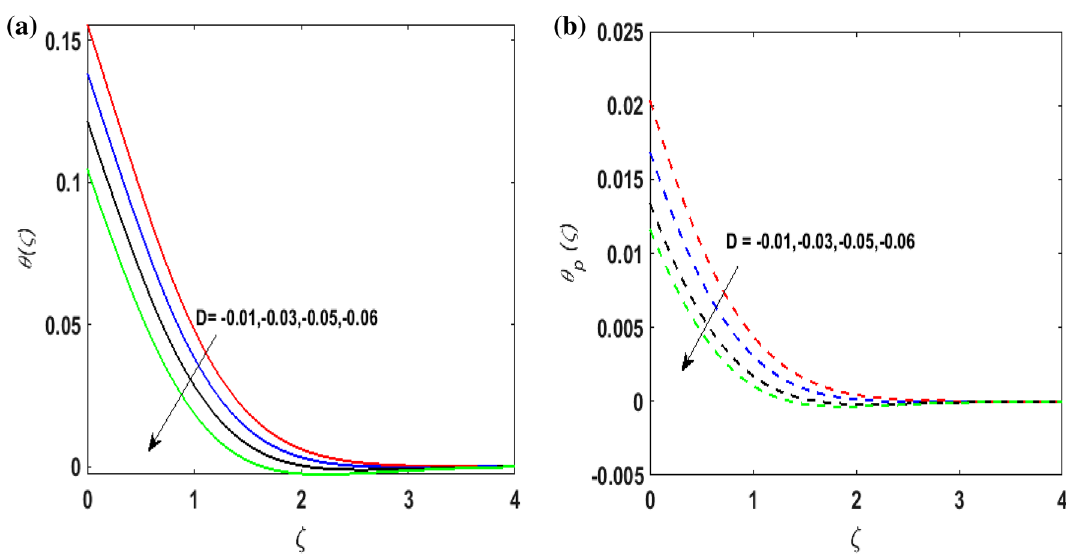
Figure 13. ( a ) θ(ζ) for various D < 0. ( b ) θ p (ζ) for various D <